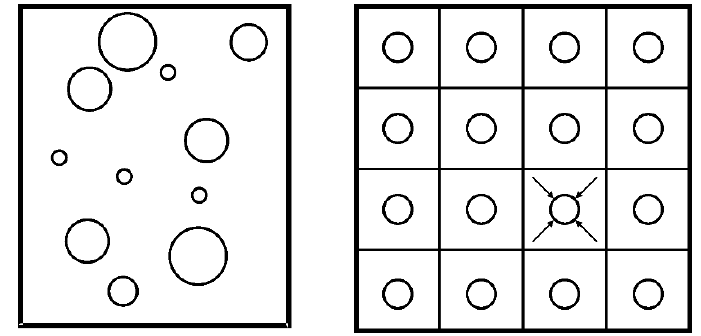
Figure 3. Ham model [29].